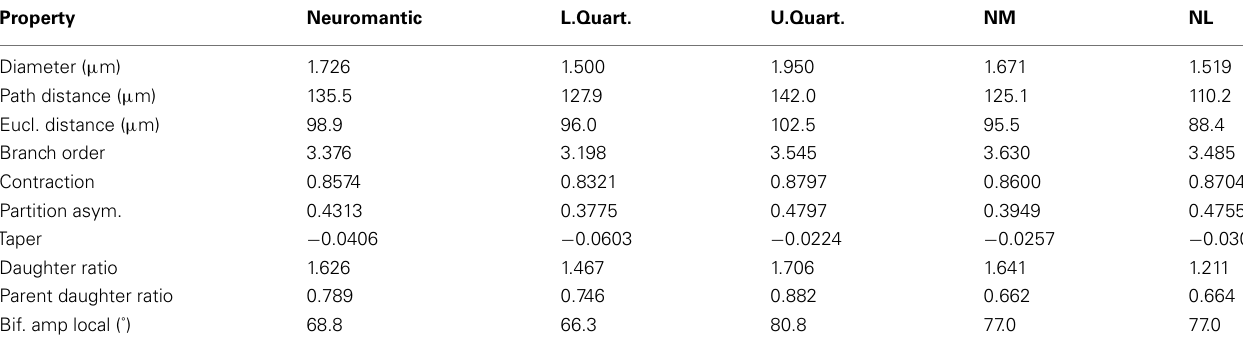
Table 4 |The median and interquartile branch statistics for each of the ten reconstructions performed by the participants.